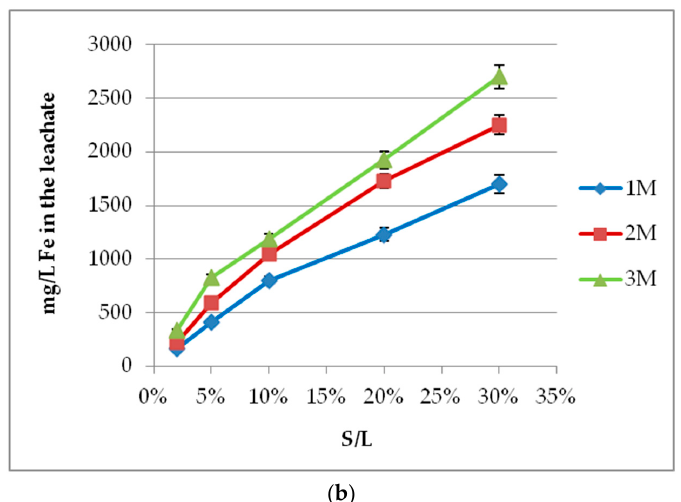
Figure 3. Acid molarity effect on ( a ) Sc; ( b ) Fe concentration for different S/L values (2–30%) and 60 min leaching period.